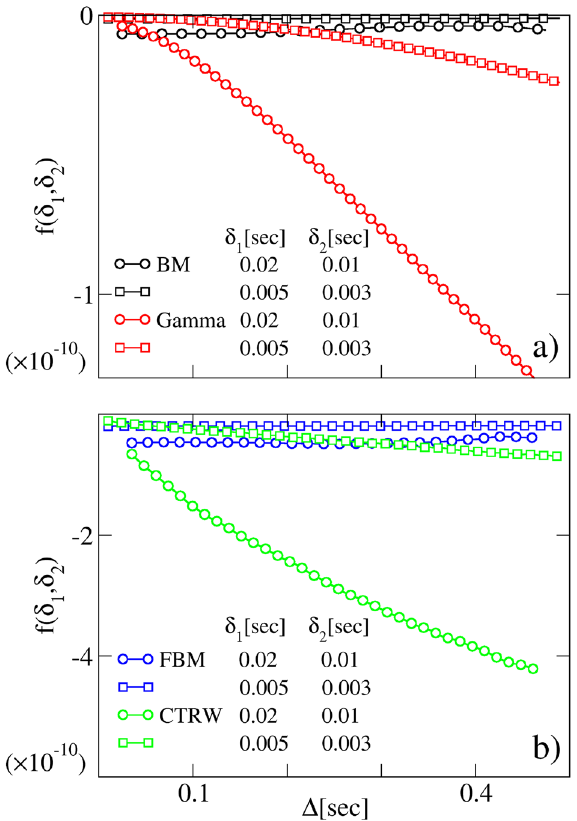
9 m 2 s 1 and g 0.01 2 10 − − = = × 9 m 2 s 1 and k 2 10 0.5 . Panel ( b ) behavior of the − − = × = 0.5 , =